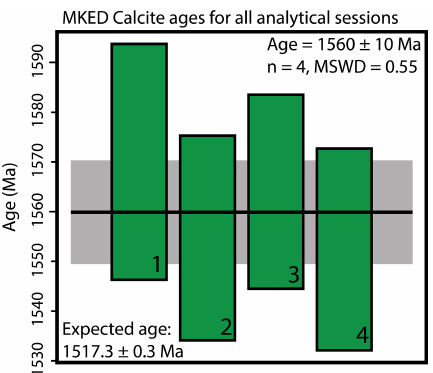
Figure A2. Demonstration of the systematic analytical offset ob- served for calcite Lu–Hf ages. Green rectangles are 95% confi- dence intervals around weighted mean ages for each session, with the session number in the bottom right corner of each rectangle. Horizontal black line shows the weighted average age of all ana- lytical sessions, with the grey rectangle showing 95% confidence interval uncertainty. The combined weighted average age for all an- alytical sessions is shown in the top right corner. The expected age is from Spandler et al. (2016). Weighted mean ages were calculated using ISOPLOTR (Vermeesch,